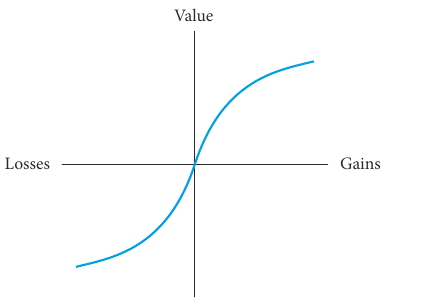
Figure 1. The value function of PT Figure 2. The probability weighting function of